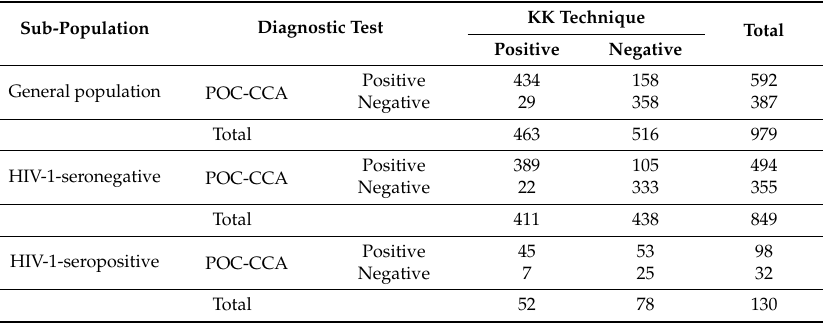
Table 3. Diagnostic performance of the point-of-care circulating cathodic antigen and the Kato-Katz technique for the diagnosis of Schistosoma mansoni infection in an adult population co-infected or not with HIV-1